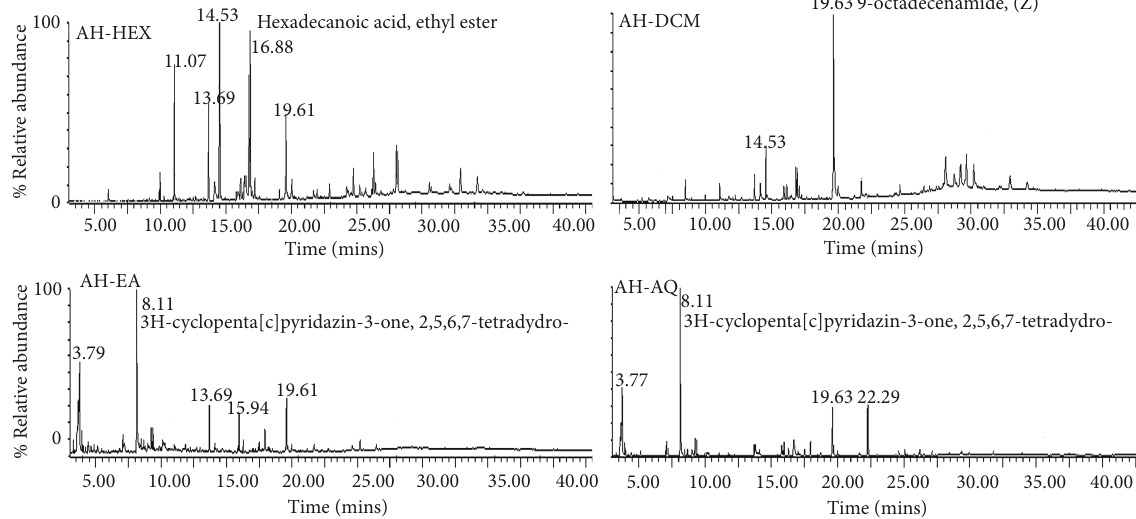
Figure 5: GC-MS fingerprint of A. hispidum . The most abundant secondary metabolites were identified as ethyl hexadecanoate (AH-HEX), 9(Z)-octadecenamide (AH-DCM), and 2,5,6,7-tetrahydro-3H-cyclopenta[c]pyridazin-3-one (AH-EA/AH-AQ), with retention times of approximately 14.53, 19.63 and 8.11mins, respectively. AH-HEX � hexane fraction, AH-DCM � dichloromethane fraction, AH-EA � ethyl acetate fraction, AH-AQ � aqueous